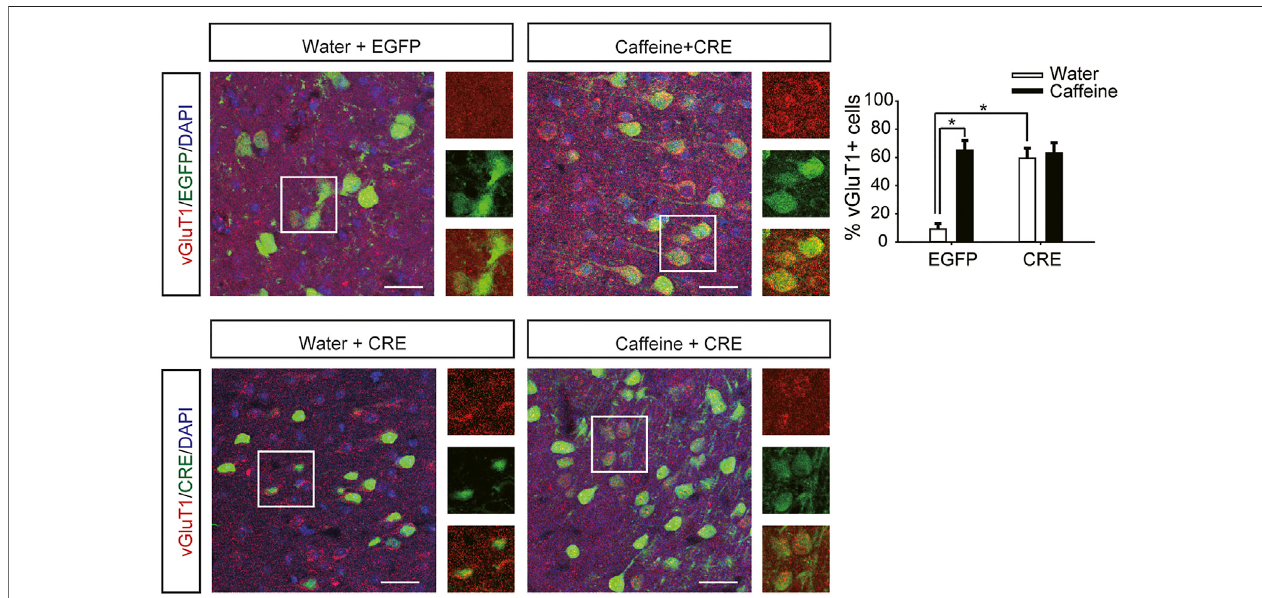
FIGURE 5 | Selective deletion of vHPC A 2A Rs increases vGluT1 expression. Caffeine markedly induced vGluT1 expression in mice transfected with pAAV-EGFP but not in mice transfected with pAAV-CRE. pAAV-CRE transfection increased vGluT1 levels in mice exposed to water alone as well. Representative images (left) and Data (right) are presented as the mean ± SEM; n = 27 fi elds per group (3 fi elds per section, three sections per mouse, three mice per group). Scale bar = 30 μ m.